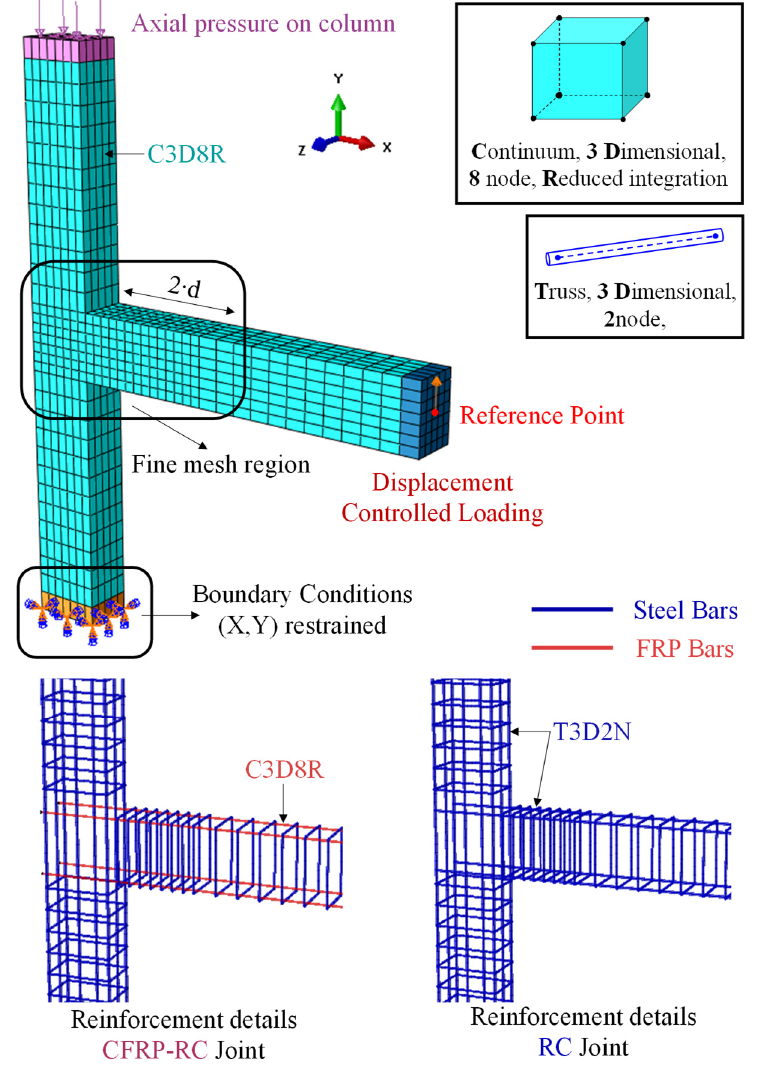
Figure 9. Details of the 3D FE simulation used to simulate the CFRP-RC and RC beam-column joints.